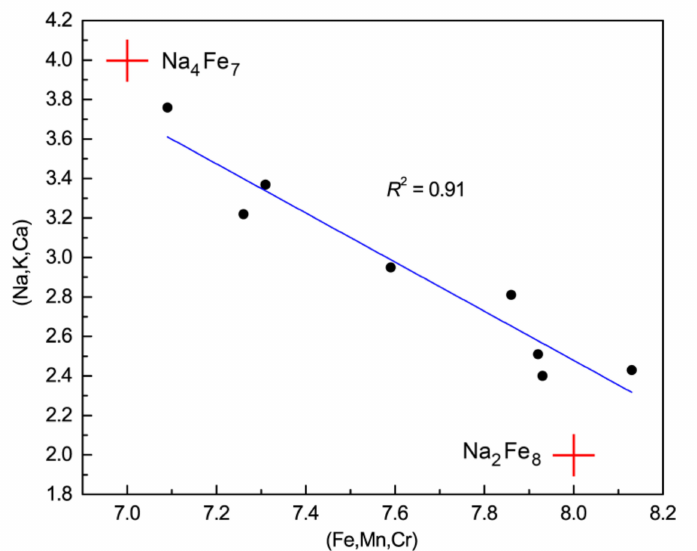
Figure 3. Variations of Σ (Na,K,Ca) vs. Σ (Fe,Mn,Cr) in the analyzed xenophyllite grains from the Augustinovka meteorite. Data in the atoms per formula unit ( apfu ) recalculated on 24 oxygen atoms. Red crosses denote the positions corresponding to ideal Na 4 Fe 7 (PO 4 ) 6 (top left) and Na 2 Fe 8 (PO 4 ) 6 (bottom right). The compositions are listed in Table